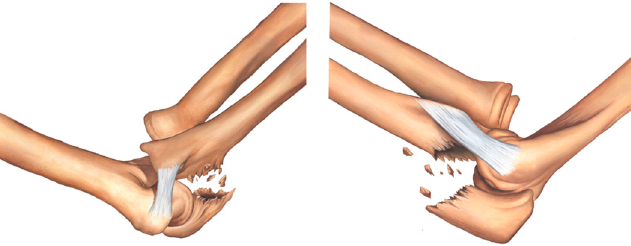
Figure 2. Type IA fracture—transolecranon fracture of the proximal ulna with no involvement of the sublime tubercle and supinator crest.